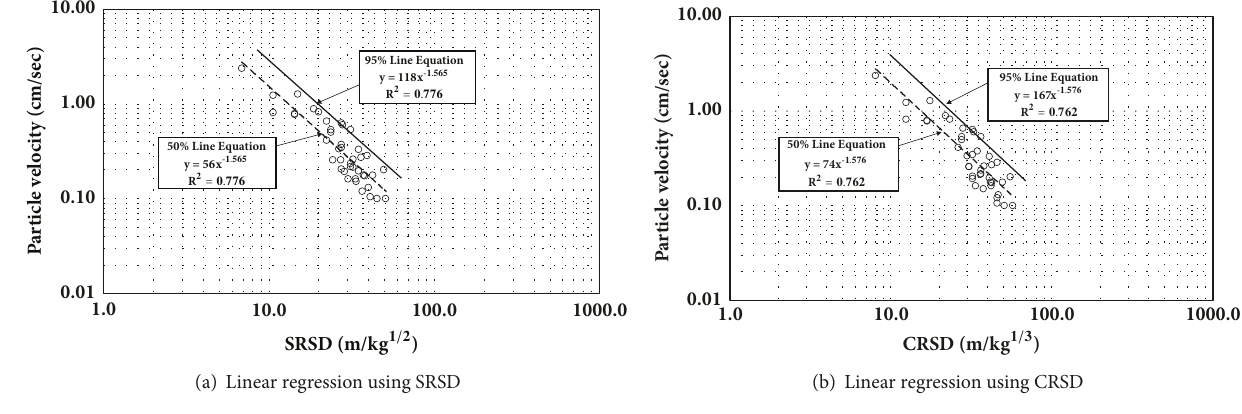
Figure 13: Determination of equation for predicting blasting-induced vibration. Table 4: Maximum charge per delay with vibration value and distance (unit: